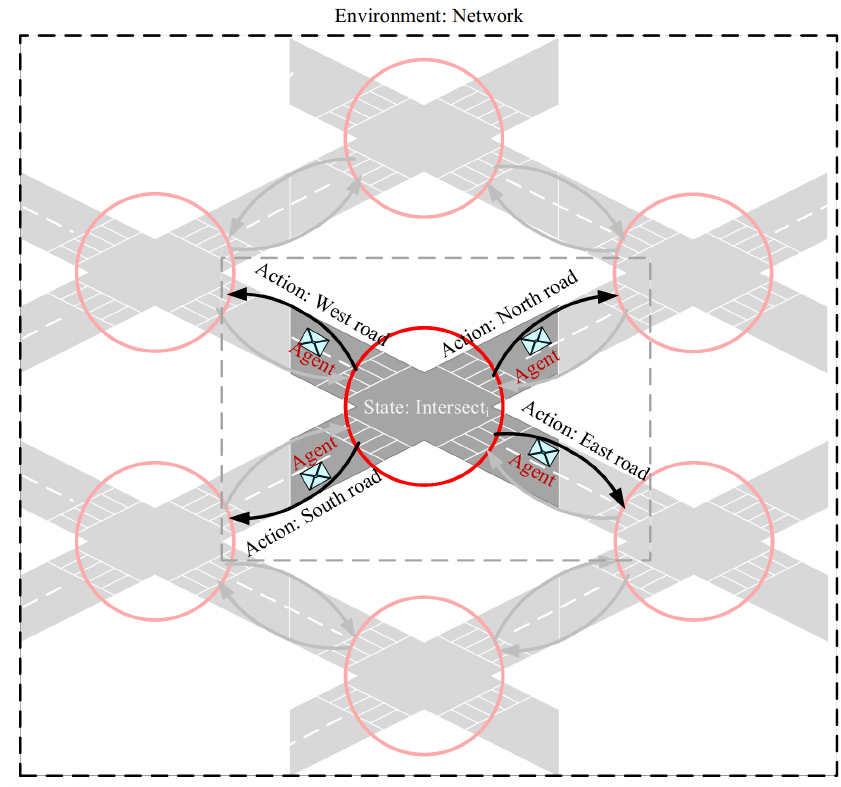
Figure 7. Different components in I2I routing model in